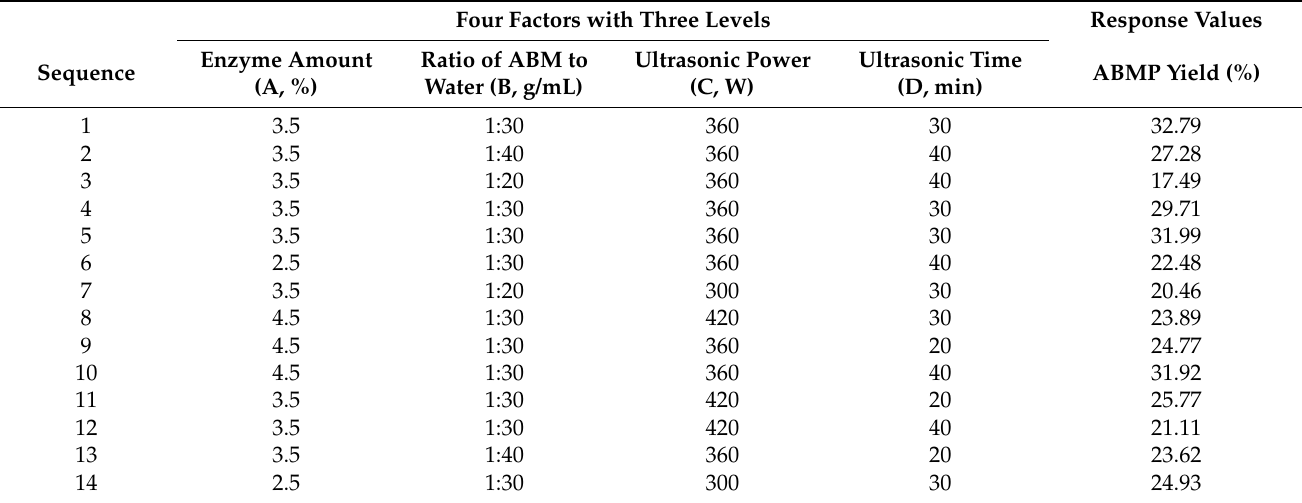
Table 1. Box-Behnken design matrix and response values for the ABMP yield. Four Factors with Three